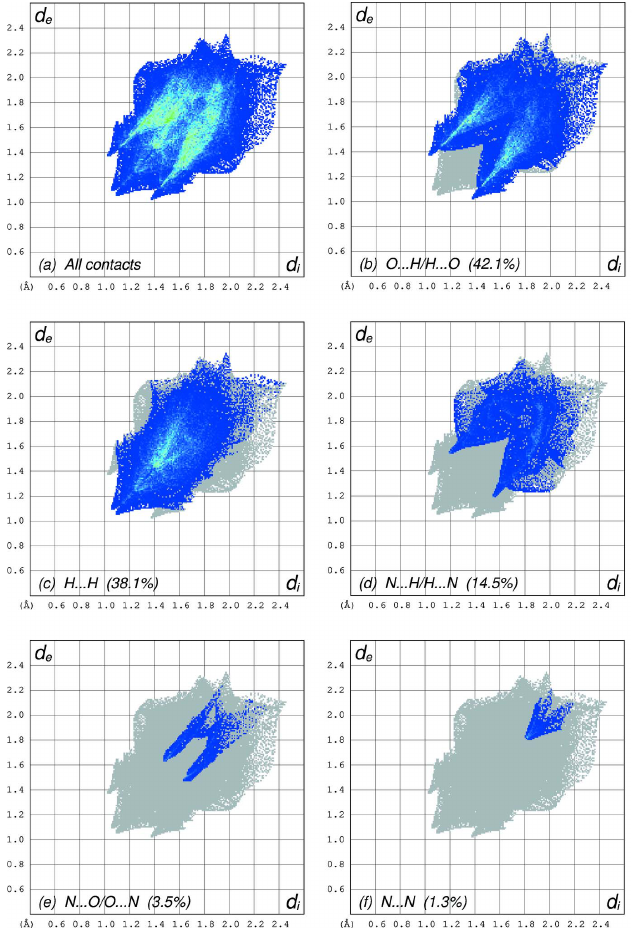
Figure 5 Fingerprint plots obtained from a Hirshfeld surface analysis for I at 90 K using CrystalExplorer (Spackman et al. , 2021). ( a ) All contacts, ( b ) O (cid:2)(cid:2)(cid:2) H/H (cid:2)(cid:2)(cid:2) O (42.1% coverage), ( c ) H (cid:2)(cid:2)(cid:2) H (38.1%), ( d ) N (cid:2)(cid:2)(cid:2) H/H (cid:2)(cid:2)(cid:2) N (14.5%), ( e ) N (cid:2)(cid:2)(cid:2) O/O (cid:2)(cid:2)(cid:2) N (3.5%), ( f ) N (cid:2)(cid:2)(cid:2) N (1.3%). All other contacts are negligible. Acta Cryst. (2022). E 78 , 984–988